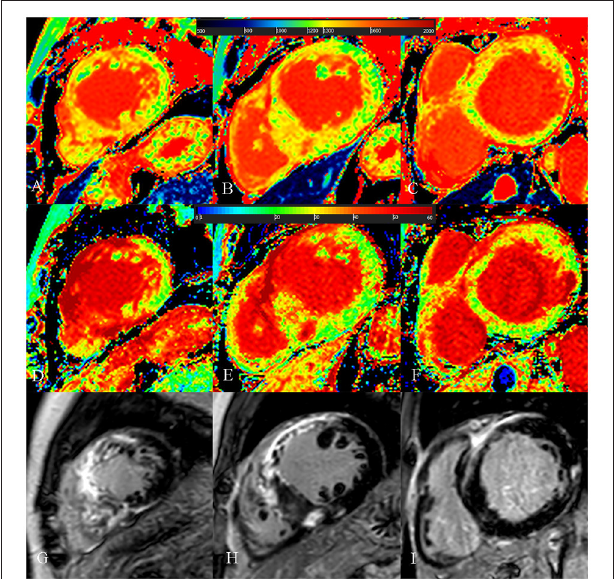
FIGURE 4 | A 54-year-old male with diffuse septum hypertrophic cardiomyopathy. (A – C) Native T1 mapping of the apical, mid-, and basal portions of the left ventricular (LV) myocardium revealed higher global native T1 (1,359.67ms). (D – F) Extracellular volume fraction (ECV) of the apical, mid-, and basal portions of the LV myocardium showed higher ECV (38.9%). (G – I) Late gadolinium enhancement (LGE) images of the apical, mid-, and basal portions of the LV myocardium showed multiple LGE. The maximal LV wall thickness was 24.3mm, left atrial diameter was 55mm, and the LV outflow tract gradient pressure was normal. He had non-sustained ventricular tachycardia but no family history of sudden cardiac death (SCD) and unexplained syncope. He had LGE/LV mass ≥ 15% (LGE/LV mass: 46.3%) and end-stage systolic dysfunction but no apical aneurysm. He was stratified as having high SCD risk under the 2014 European Society of Cardiology guidelines (5-year SCD probability: 5.93%) and enhanced American College of Cardiology/American Heart Association guidelines. He underwent the placement of ICD 6 months after cardiac MRI examinations. Higher global native T1 mapping and ECV values also indicated poor